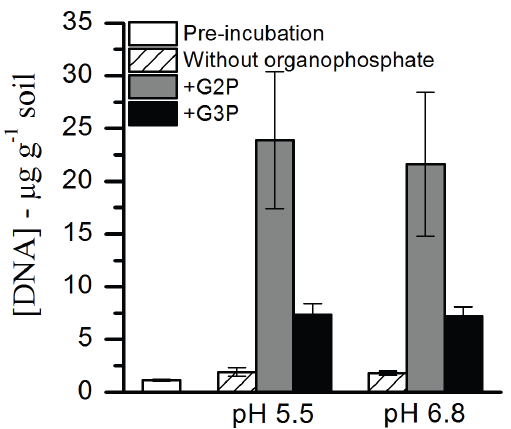
Figure 2. DNA extractions from ORFRC subsurface sediments. DNA concentrations pre- and post-incubations (pH 5.5 and pH 6.8) amended with G2P, G3P, and without organophosphate. Error bars indicate standard deviation of replicate treatments (n=3).